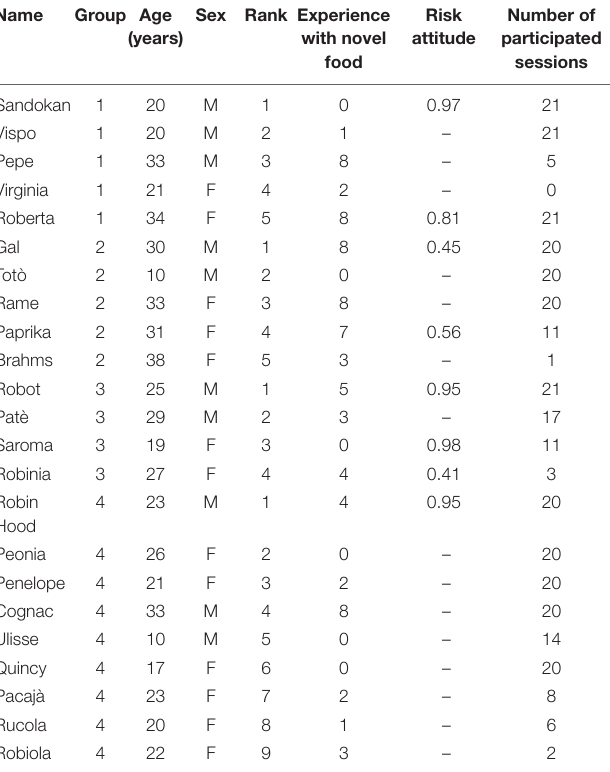
TABLE 1 | Individual characteristics of the study subjects, including their name, group, age (in years), sex, rank (with 1 referring to the highest-ranking individual in each group), experience with novel food (as the number of experiments on neophobia in which each subject had participated before being tested), risk attitude (as the mean proportion of trials in which the subject had chosen the risky over the safe option in a decision-making task; De Petrillo et al., 2015) and number of total sessions of conditions A and B in which each subject